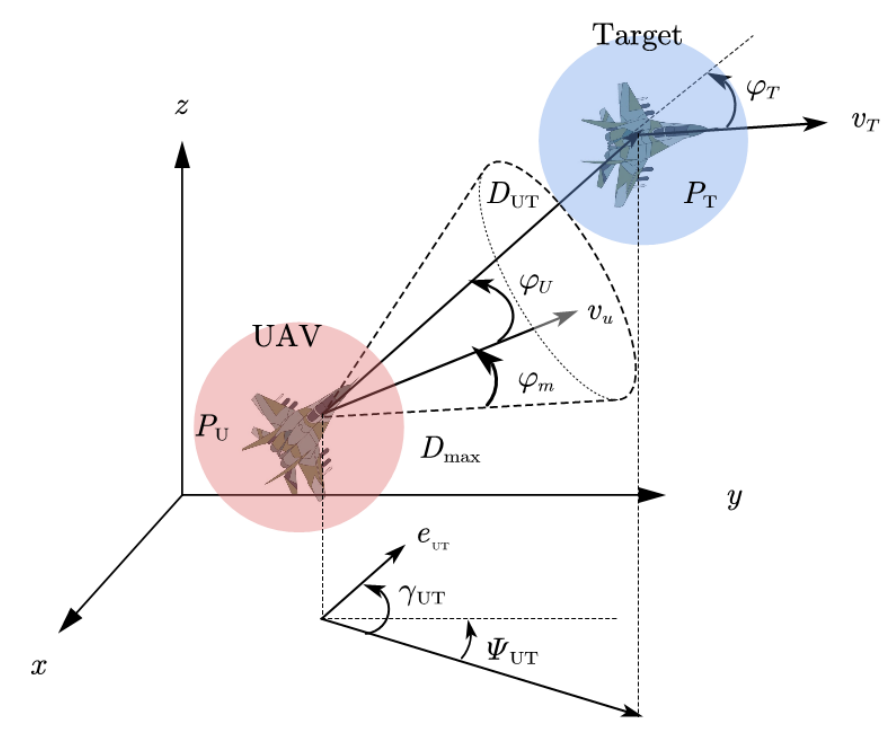
Figure 2. Situation assessment